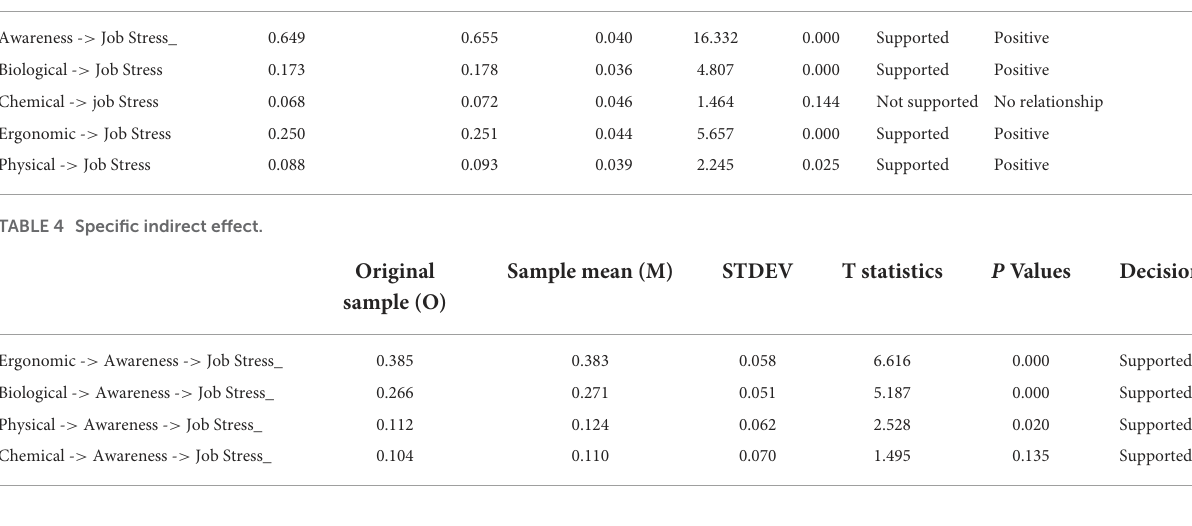
TABLE 2 R square.